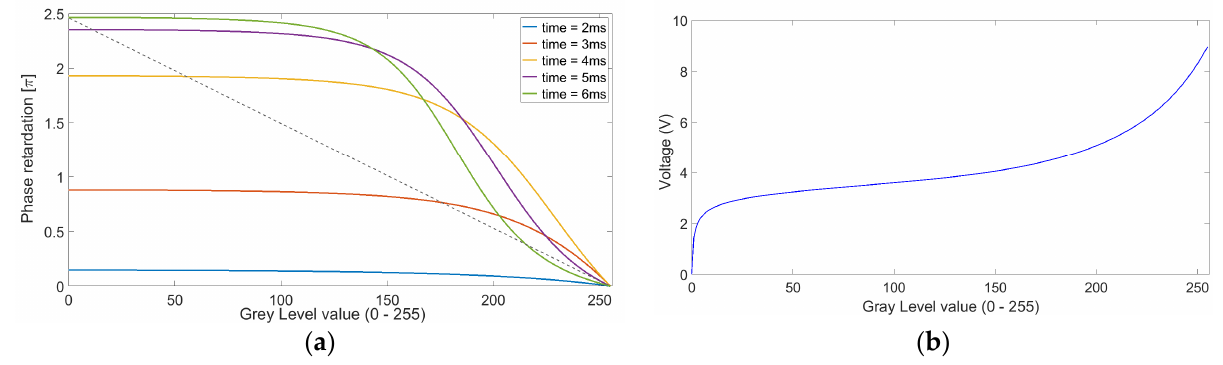
Figure 4. ( a ) Phase retardation values as a function of gray level values. The given case is for HBM-2 material (LC layer thickness d = 2.5 μ m, i/g = 1.5/0.5 μ m, light source wavelength λ = 520 nm). The linear dashed line indicates the voltage calibration corresponding to linear phase change. ( b ) DC voltages as a function of gray level values corresponding to a linear phase change.